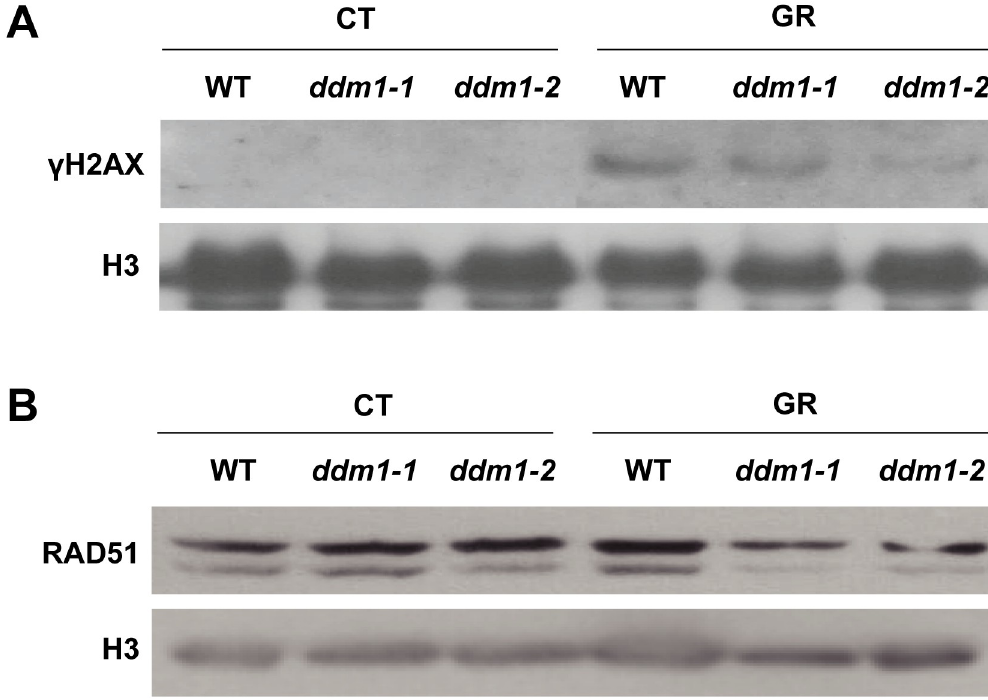
Fig 5. ddm1 mutants have defects in induction of γ -H2AX and RAD51. (A) Immunoblot of γ -H2AX and (B) RAD51 in WT and ddm1 mutants after gamma irradiation. CT, control; GR, gamma radiation.